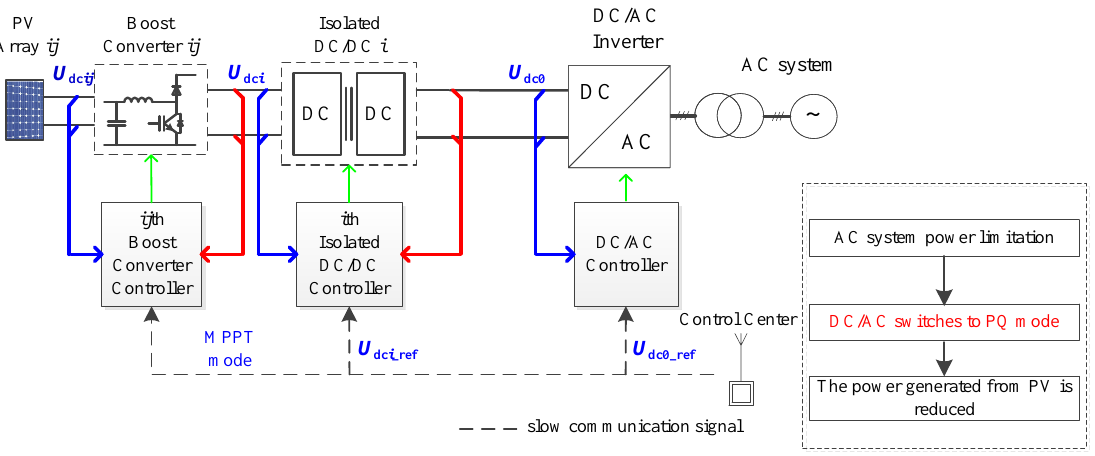
Figure 9. Improved control scheme of PV integration system.